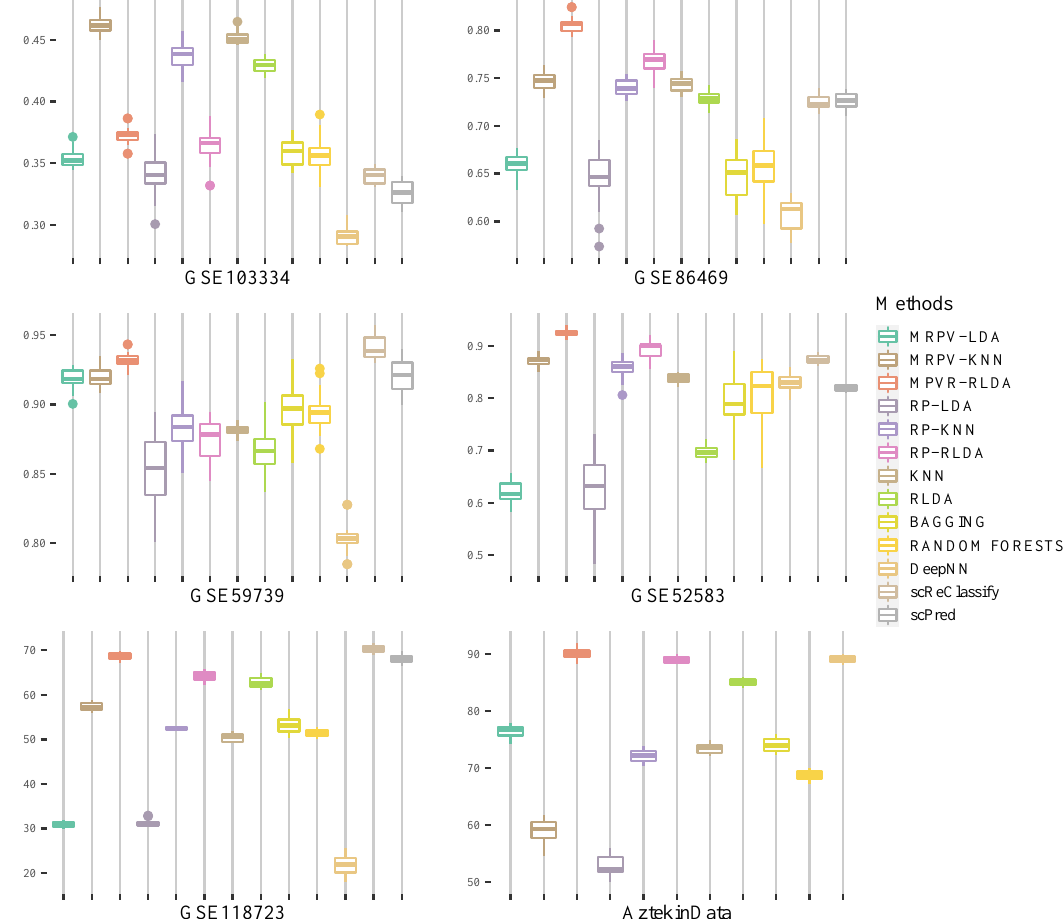
Figure 3. Classification performance of the proposed MRPV framework (MRPV-LDA, MRPV-KNN, MRPV-RLDA) compared to other ten classification methods for the dataset GSE103334, GSE86469, GSE59739, GSE52583, GSE118723, and AztekinData. Evaluation testing is made by examining Accuracy. Boxplots imprint the values via 100 independent executions for each